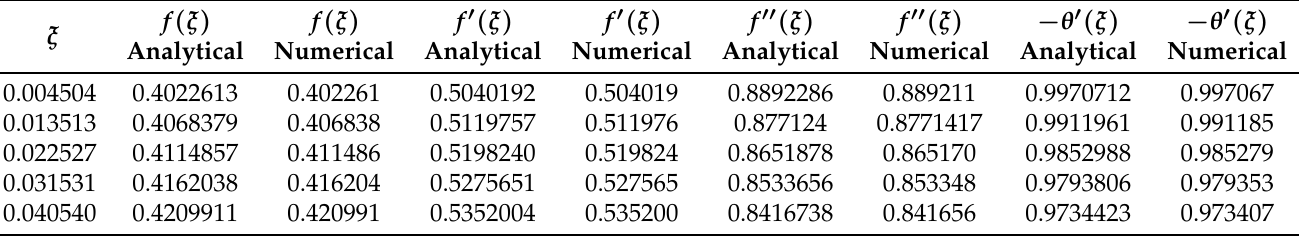
Table 3. Numerical comparison of HAM with